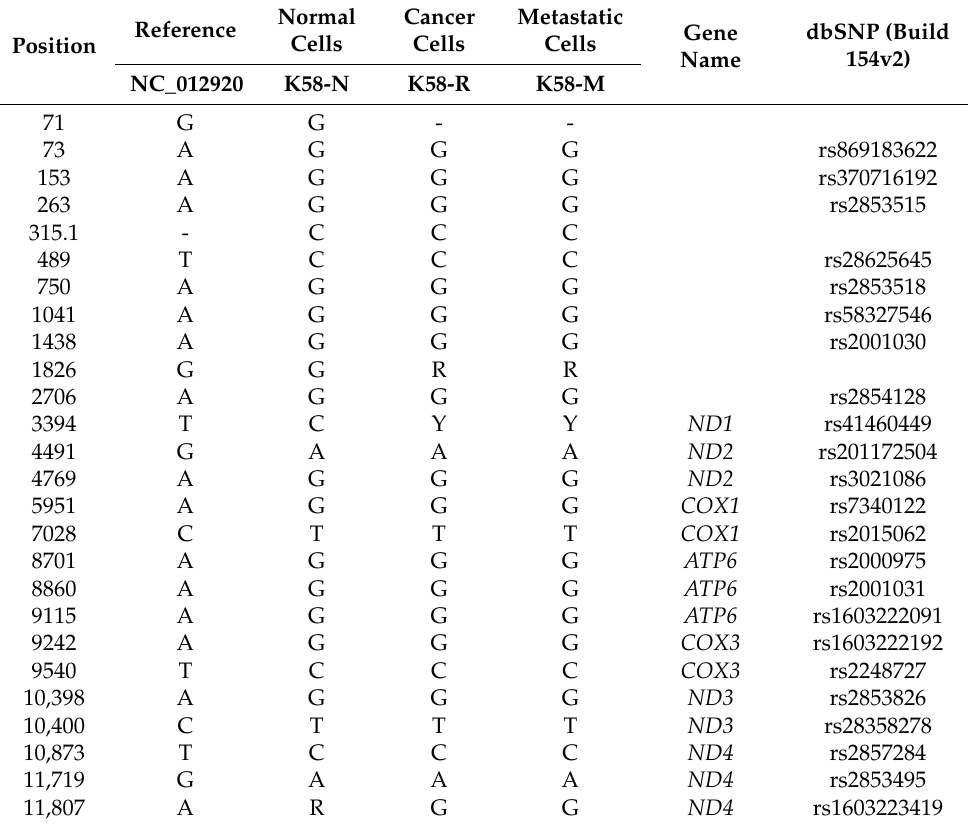
Table 2. Mitochondrial DNA mutation sites of three